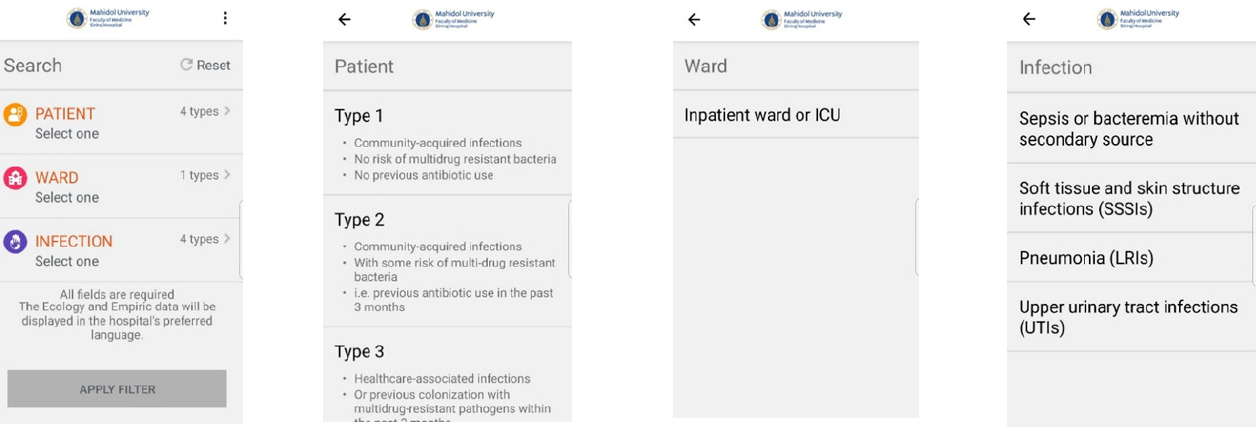
Figure 1. The DigitalAMS TM application interfaces.